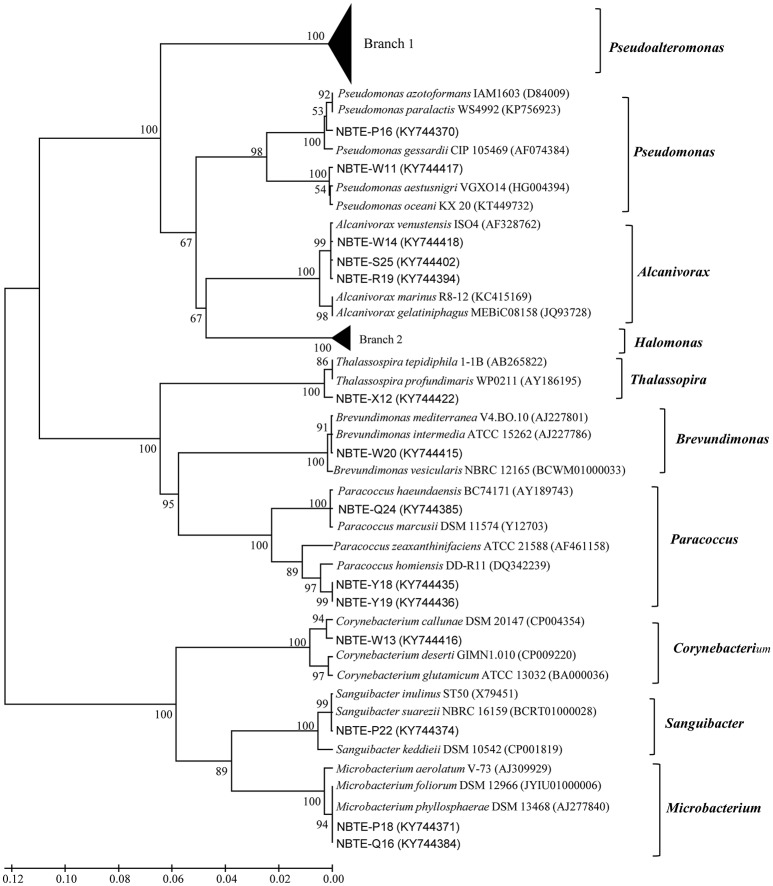
Neighbor-joining phylogenetic tree of cultivable bacterial strains from eight different depths in the New Britain Trench based on 16S rDNA sequences.